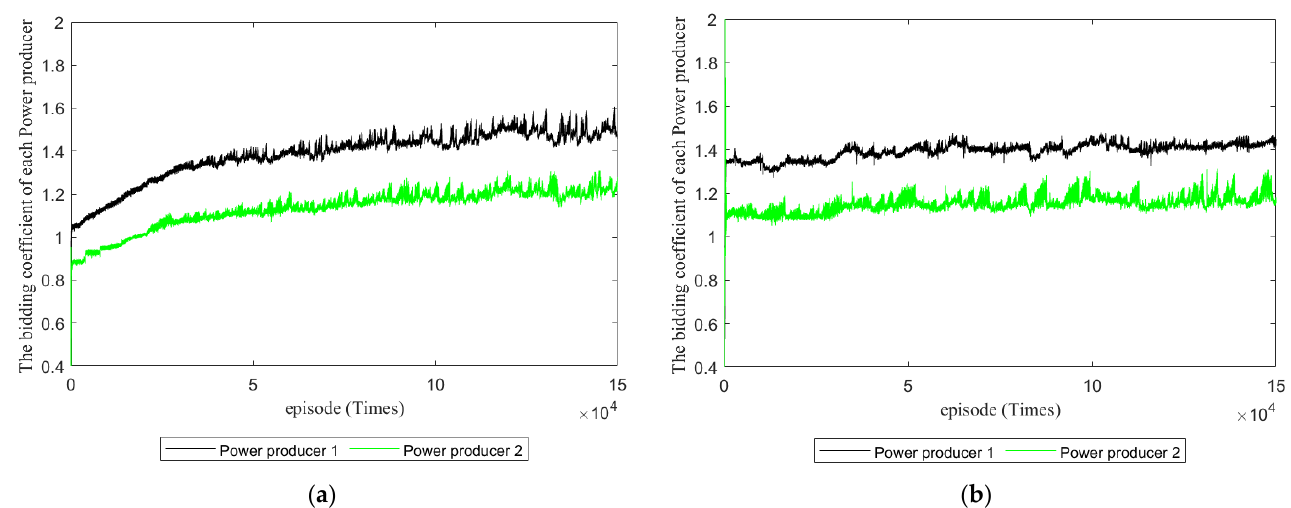
Figure 8. ( a ). The bidding coefficients of each power producer with no price boundary. ( b ). The bidding coefficients of each Power producer with a price boundary.